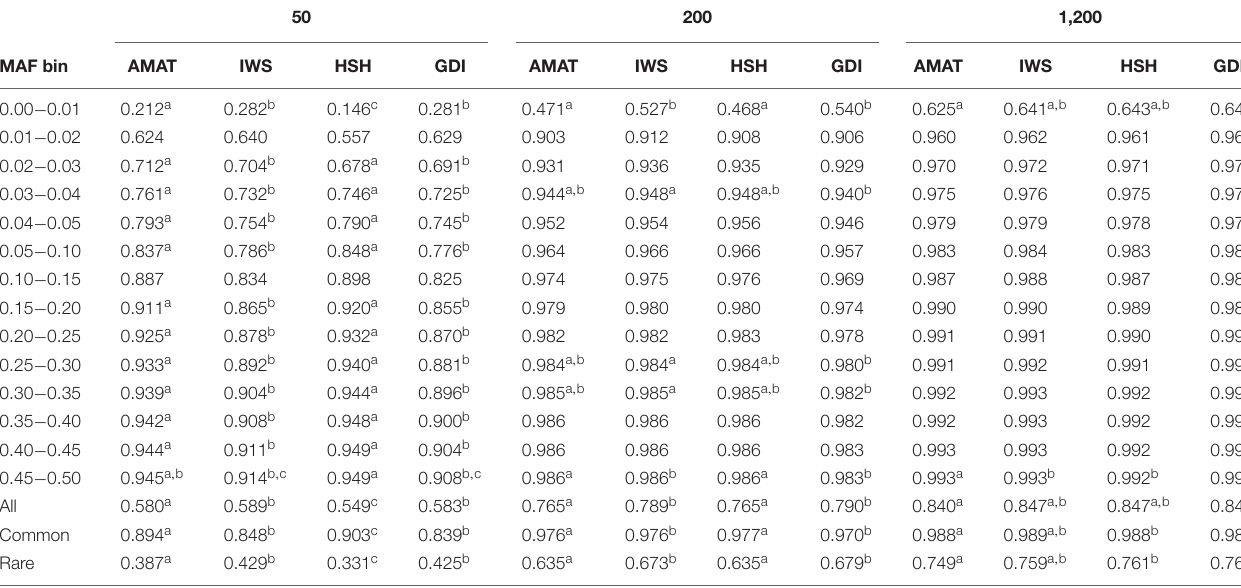
TABLE 4 | Accuracies for reference populations of 50, 200, and 1,200 individuals and increasing MAF of the variants considered, all variants, the rare variants (MAF < 0.05), or the common variants (MAF ≥ 0.05). 50 200